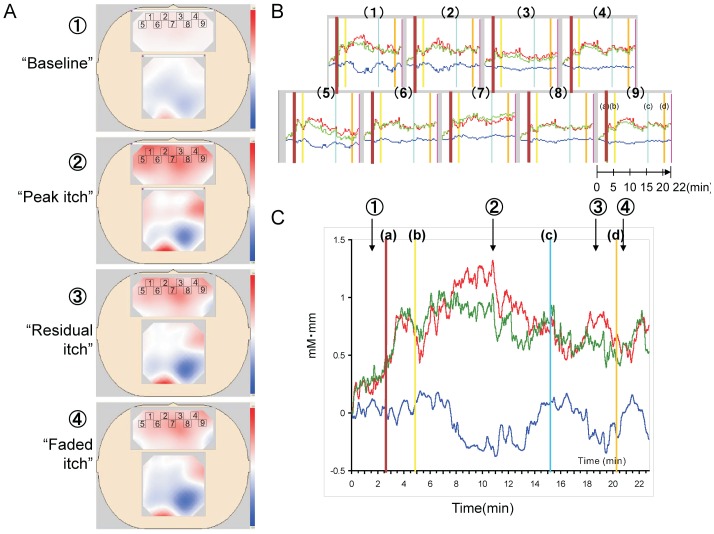
Brain imaging and dynamic signals in response to long-lasting itch stimulation.(A) Typical NIRS images of (1) pre-stimulation, (2) peak itch sensation, (3) residual itch, and (4) faded itch sensation. The small rectangles in the frontal areas correspond to the location of channel 1 through 9. (B) The traces of channels 1 through 9 in the frontal area showed dynamic changes in [HbO2] (red), [HbR] (blue), and [HbT] (green) with itch stimulation. (C) An expanded view of channel 1. (a) time of 1st scratch stimulus, (b) time of skin prick and histamine application, (c) time of wiping off histamine solution, and (d) time of 2nd scratch stimulus. Times indicated by 1,2,3, and 4 corresponded to the images shown in A.